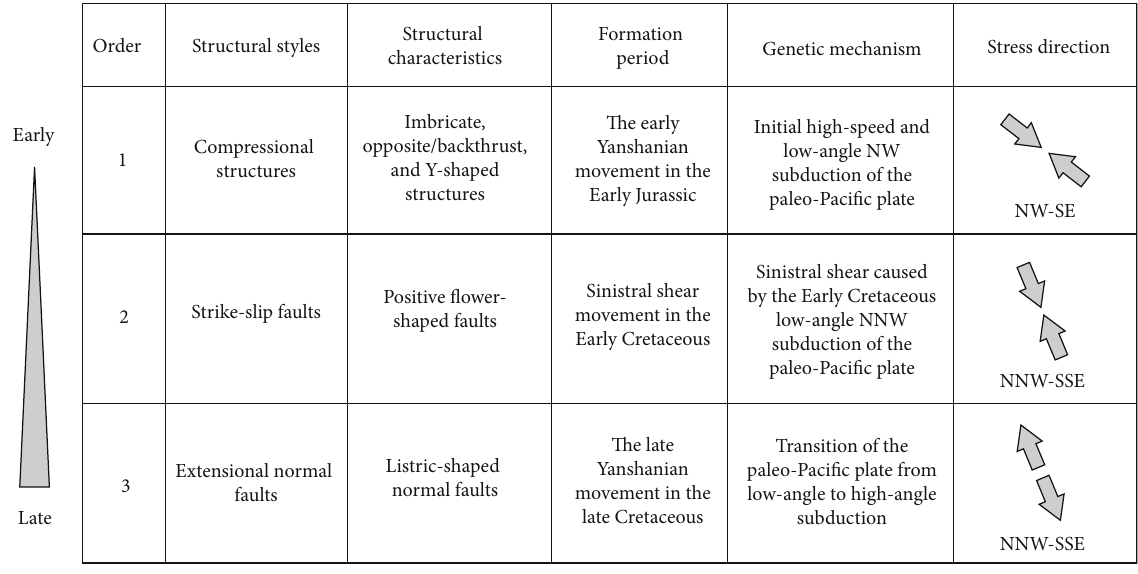
Figure 7: Structural Characteristics and genetic mechanism of the Wunansha